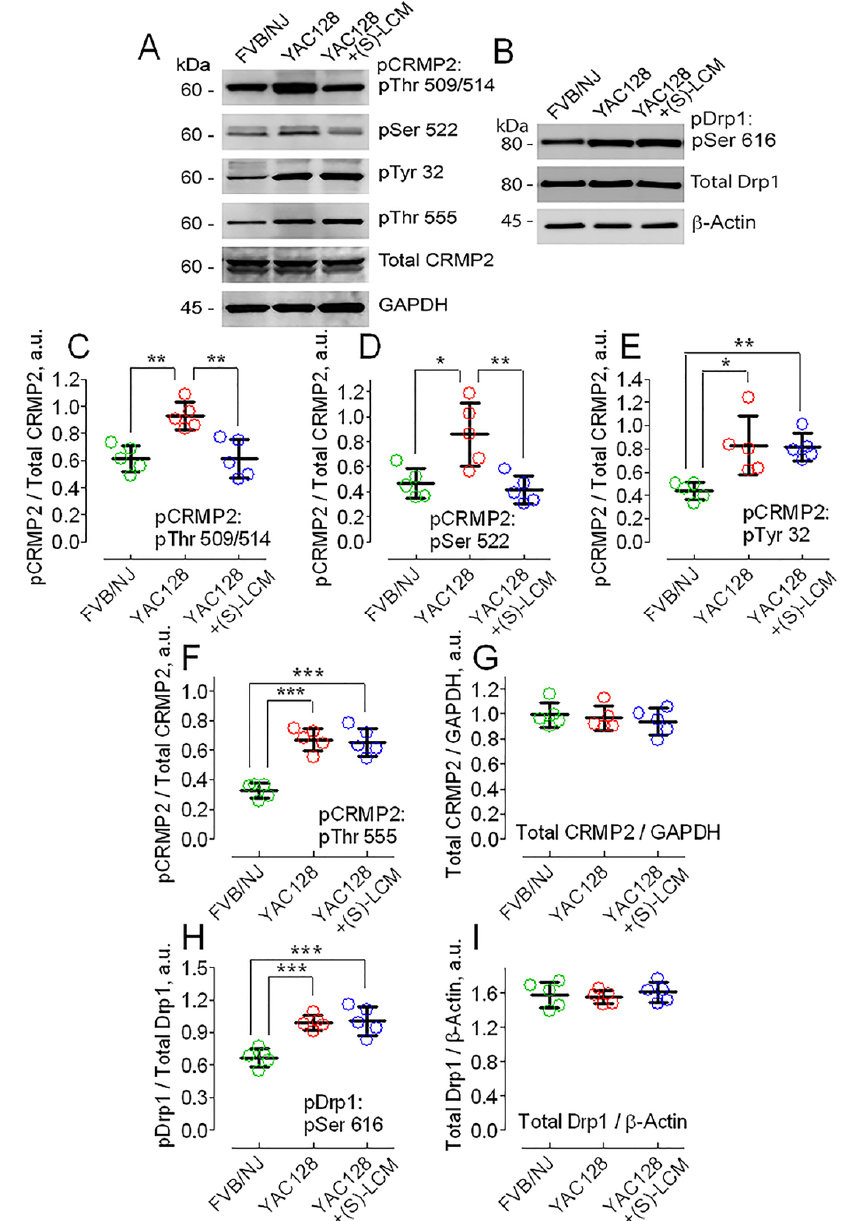
Figure 3. Increased CRMP2 ( A ) and Drp1 ( B ) phosphorylation in cultured striatal neurons from YAC128 mice compared to striatal neurons from FVB/NJ mice. (S)-lacosamide ((S)-LCM) prevented CRMP2 hyperphosphorylation but failed to diminish Drp1 phosphorylation in YAC128 neurons. YAC128 neurons were treated with 10 µM of (S)-LCM for the last 7 days prior to analysis. GAPDH and β -actin are loading controls. In ( A ) and ( B ), representative Western blots are shown. In ( C – I ), densitometry data are shown. ( C – G ), pCRMP2 normalized by total CRMP2 ( C – F ) and total CRMP2 normalized by GAPDH ( G ), respectively. In ( H , I ), pDrp1 normalized by total Drp1 and total Drp1 normalized by β -Actin, respectively. Data are mean ± SD, N = 5 separate experiments. ( C ), ** p < 0.01, comparing FVB/NJ neurons and YAC128 neurons; comparing YAC128 neurons with and without (S)-LCM treatment. ( D ), * p < 0.05 comparing FVB/NJ and YAC128 neurons, ** p < 0.01, comparing YAC128 neurons with and without (S)-LCM treatment. ( E ), * p < 0.05 comparing FVB/NJ and YAC128 neurons, ** p < 0.01, comparing FVB/NJ neurons with YAC128 neurons treated with (S)-LCM. ( F , H ), *** p < 0.01, comparing FVB/NJ neurons and YAC128 neurons with and without (S)-LCM